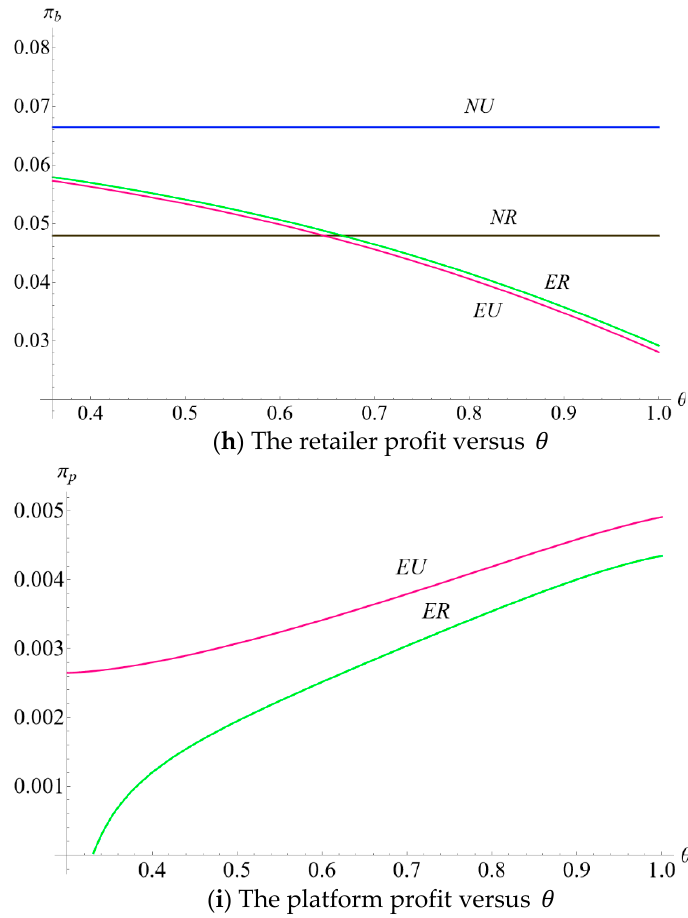
Figure 9. Optimal equilibrium versus 𝜃 .